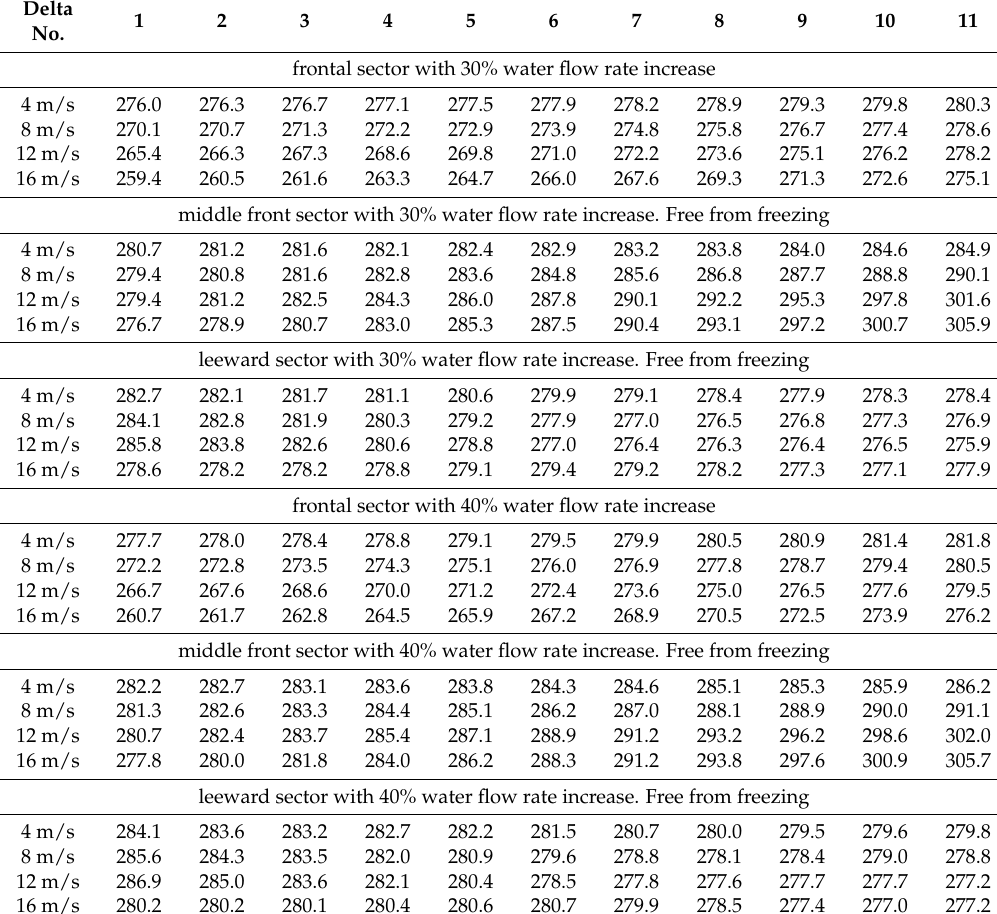
Table 1. Outlet water temperature (unit in K) of each cooling delta with water flow rate increases of 30% and